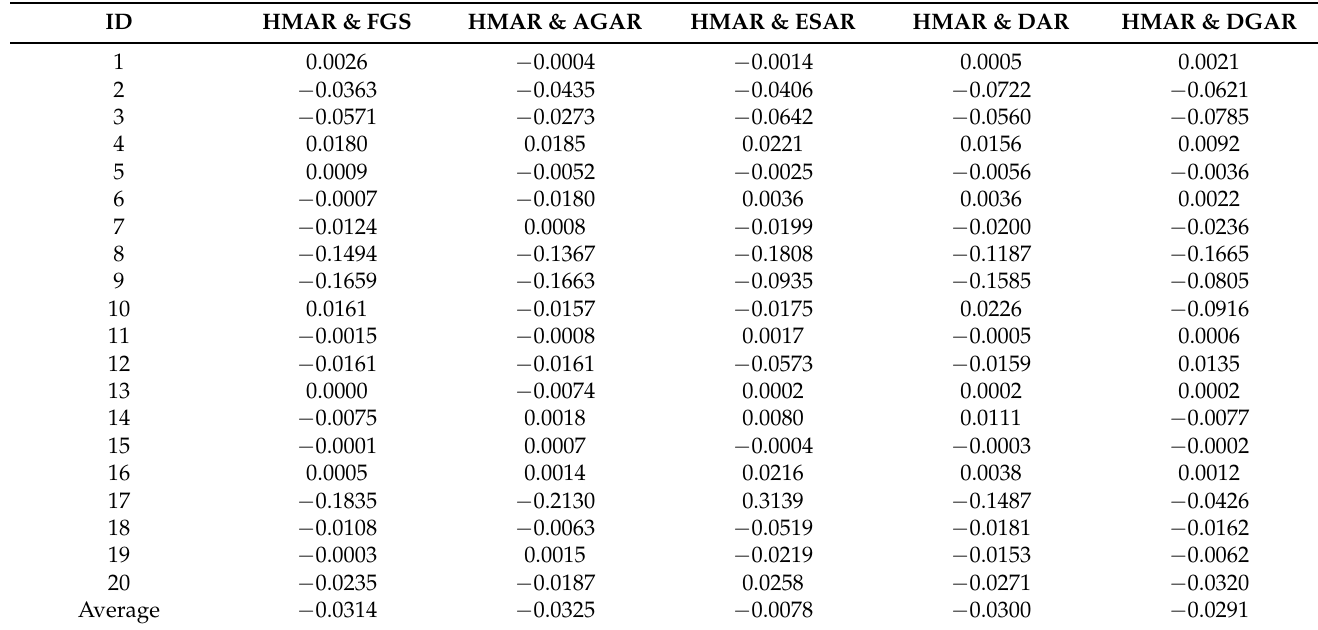
Table 8. The changing ratio related to classification accuracies based on KNN